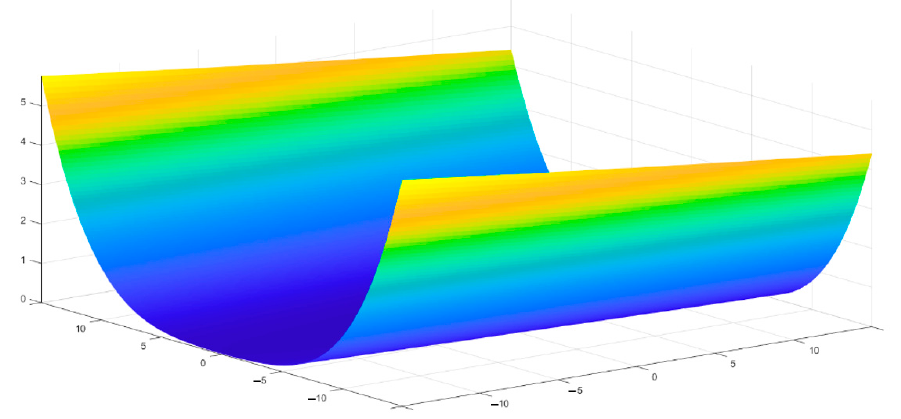
Figure 2. Improved particle swarm algorithm solution space schematic.